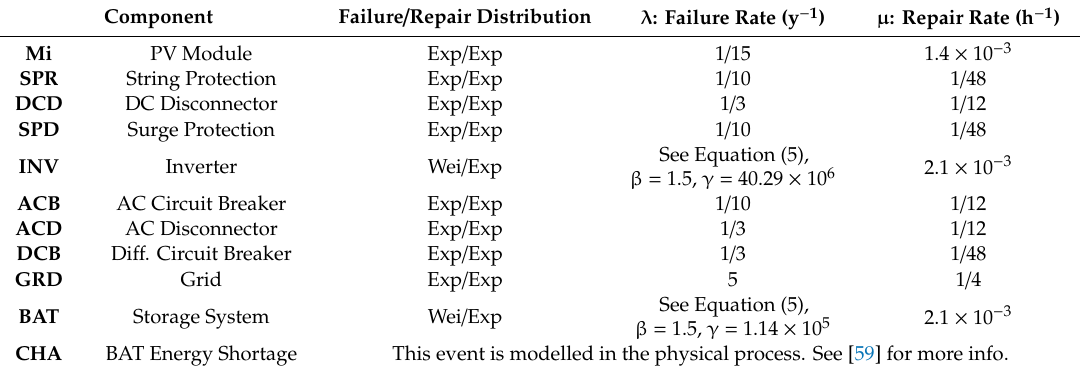
Table 4. Failure / repair rates and of the photovoltaic power plant.